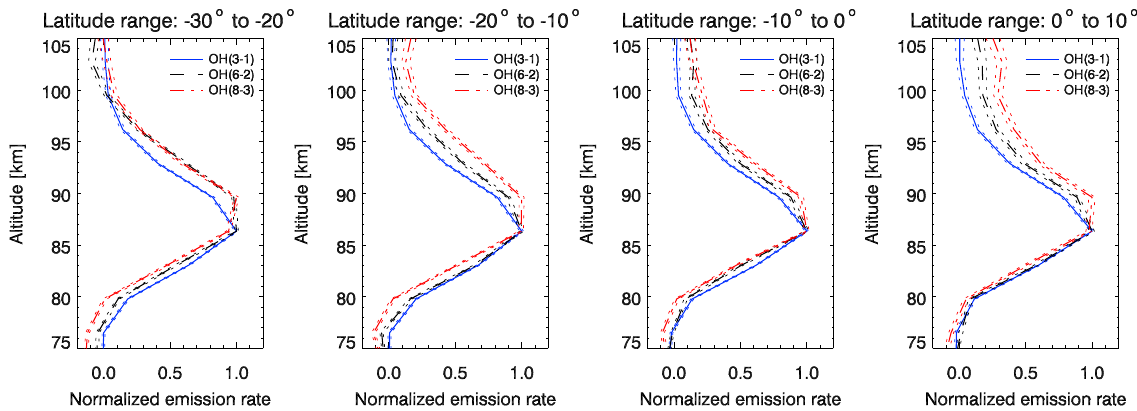
Fig. 2. Monthly and zonally averaged vertical volume emission rate profiles of the OH(3-1), OH(6-2) and OH(8-3) bands for 10 ◦ latitude bins between 30 ◦ S and 10 ◦ N and July 2005. The dotted lines indicate the retrieval errors based on the standard error of the inverted limb-radiance profiles.